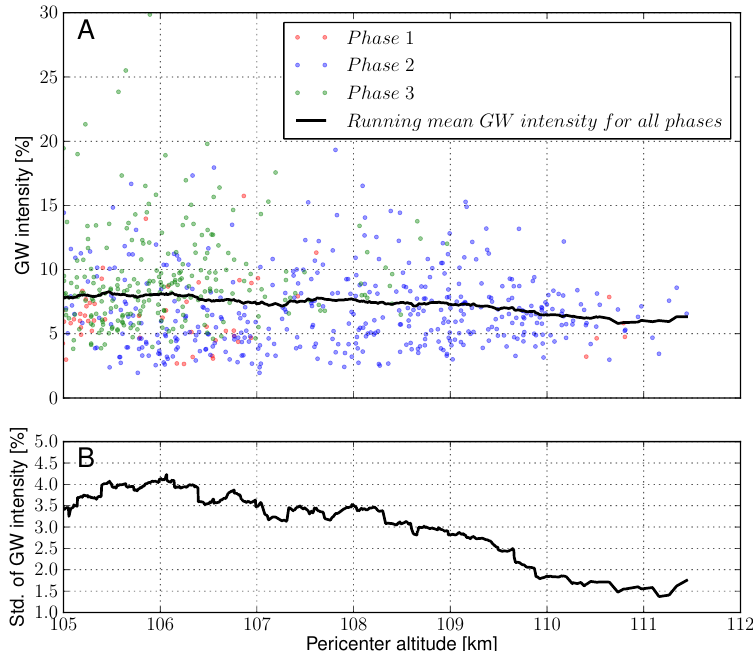
Figure 9. ( A ) Gravity wave intensity as a function of pericenter altitude. The running mean has been calculated by averaging over all the passes from all phases whose pericenter height was within km of that of the given pass. ( B ) RMS deviations with respect to the running